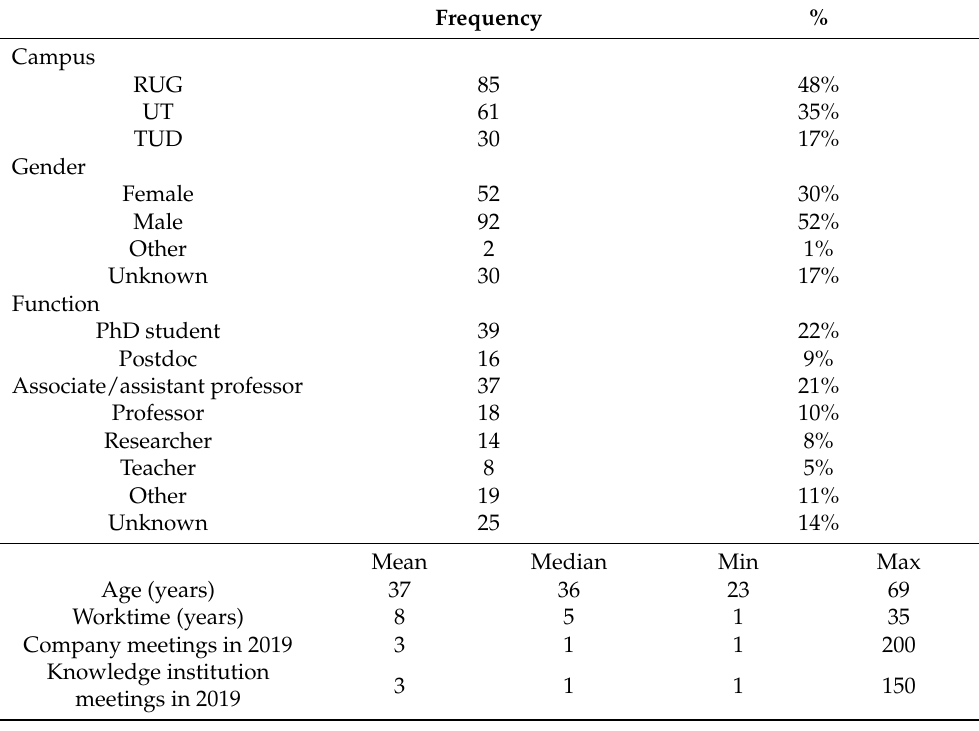
Table 13. Respondent characteristics for all